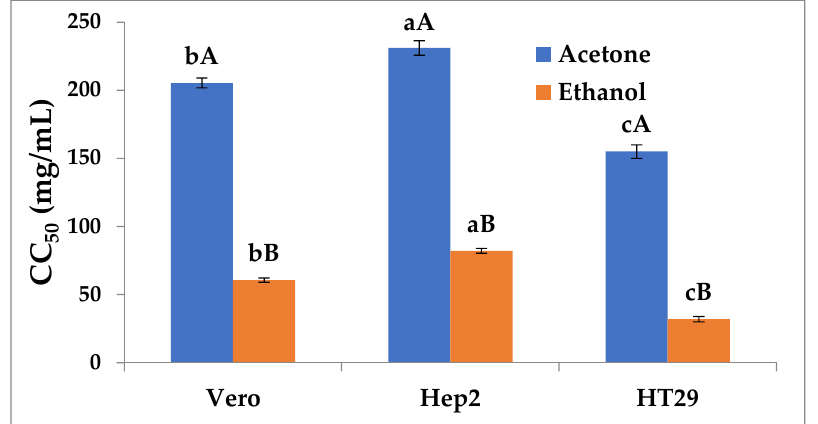
Figure 2. Cytotoxic activity of A. indicum extracts against normal and cancer cells. Small letters are used to compare each extract means between different cell lines, while capital letters are used to compare means between extract for the same cell lines.